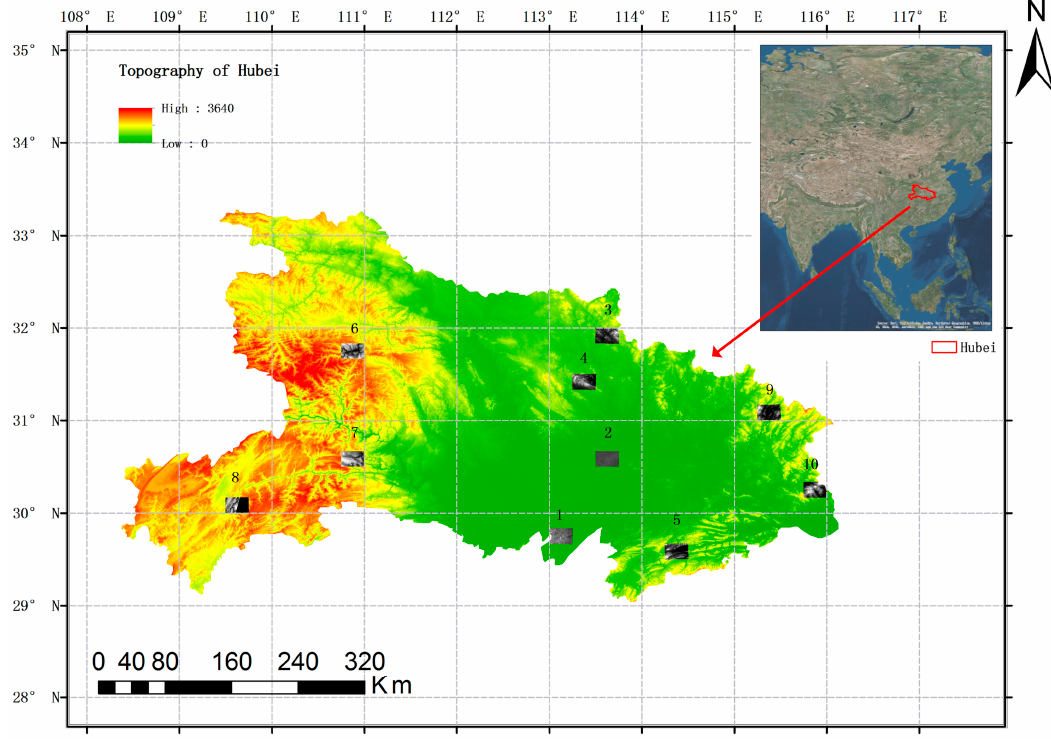
Figure 1. Distribution of the 10 sample areas in Hubei for the study. Samples 1–2 are plains, 3–5 hilly and 6–10 mountainous, with each being about 462 km 2 . The topography is from SRTM 3 in meters.